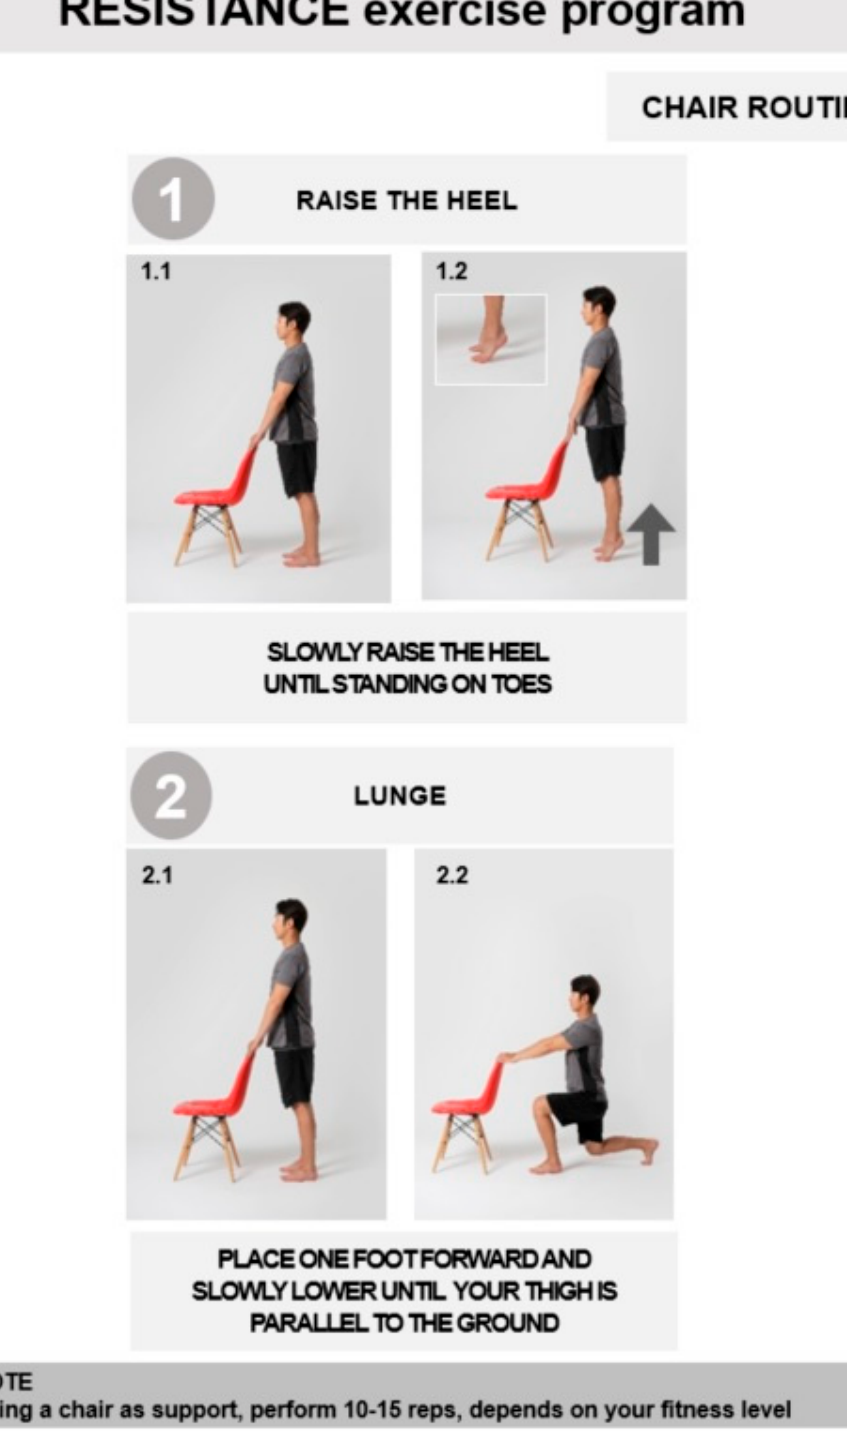
Figure A11. Detailed description and components of each movement in the “Chair routine part 1” resistance exercise.